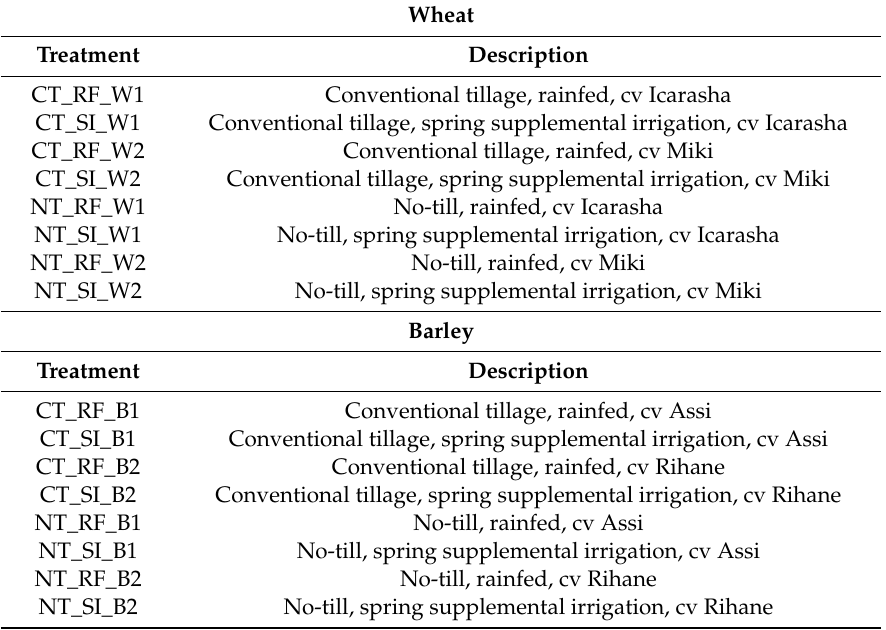
Table 1. Description of the treatments in wheat and barley experiments.